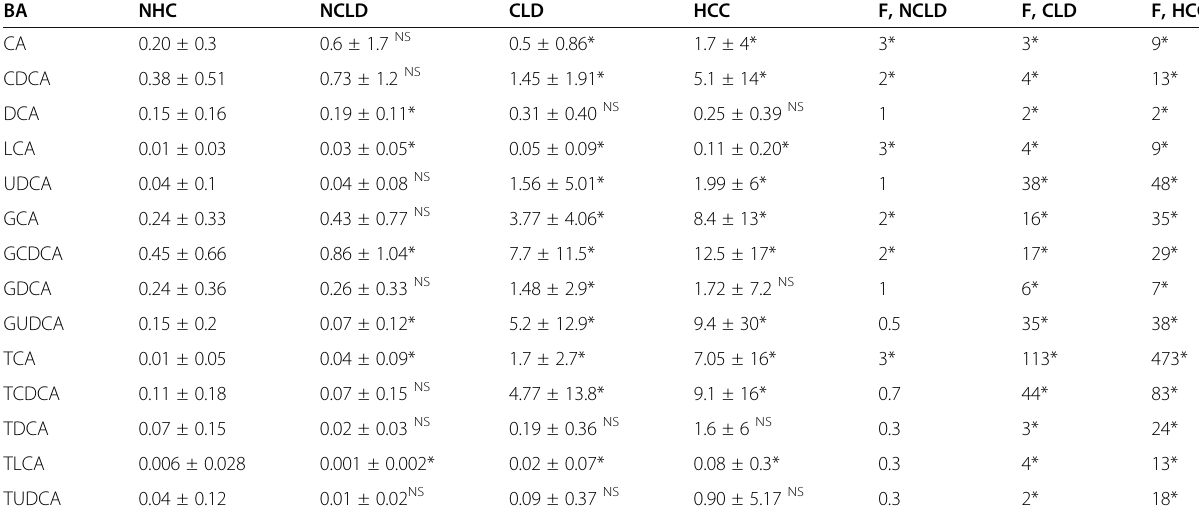
Table 2 Serum bile acids and fold changes in the studied